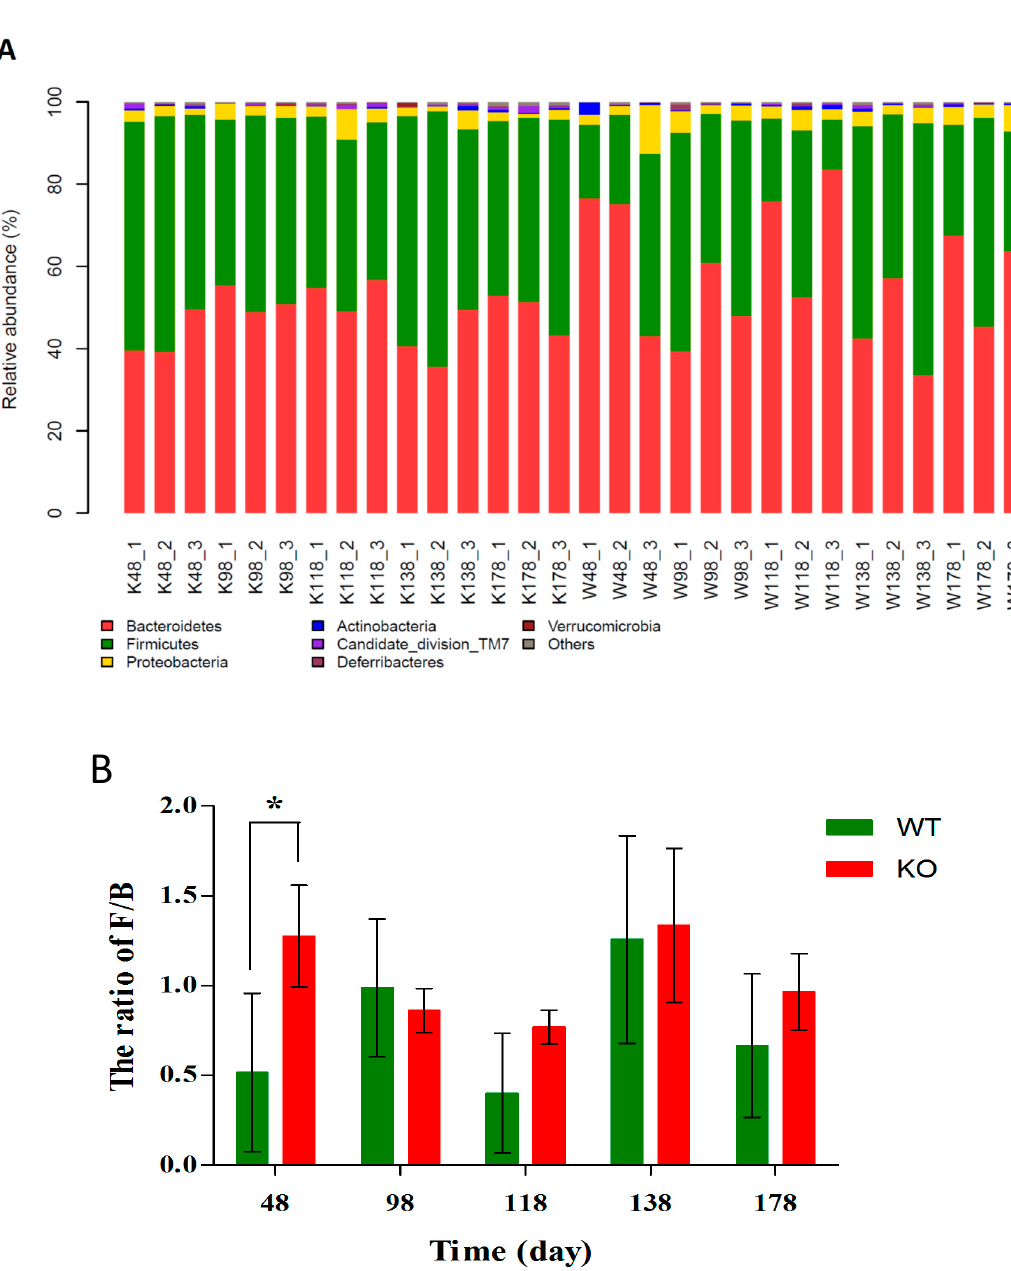
Figure 5. Different community compositions of gut microbes among Muc2 − / − and Muc2 +/+ mice at phylum levels. ( A ) Relative abundance of main phyla in the intestinal microbiota; ( B ) The ratio of Firmicutes to Bacteroides (F/B). * indicated the significant differences ( p < 0.05) between Muc2 − / − and Muc2 +/+ mice. W/WT, Muc2 +/+ mice; K/KO, Muc2 − / − mice. The sample names represented the sampling time and genotypes, e.g., K48_2 indicated the second sample collected from Muc2 − / − mice at day 48, and W48_1 indicated the first sample collected from Muc2 +/+ mice at day